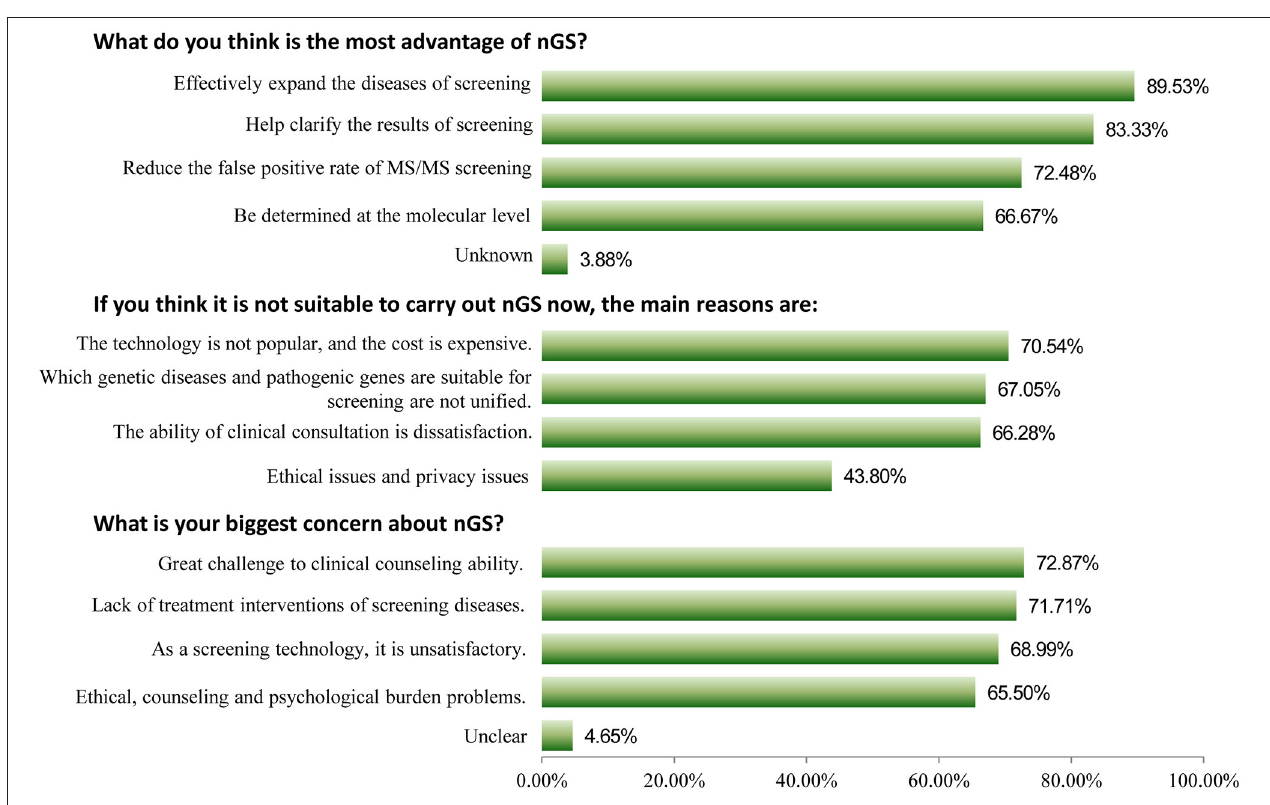
FIGURE 1 | Three key issues about attitudes toward newborn genetic screening